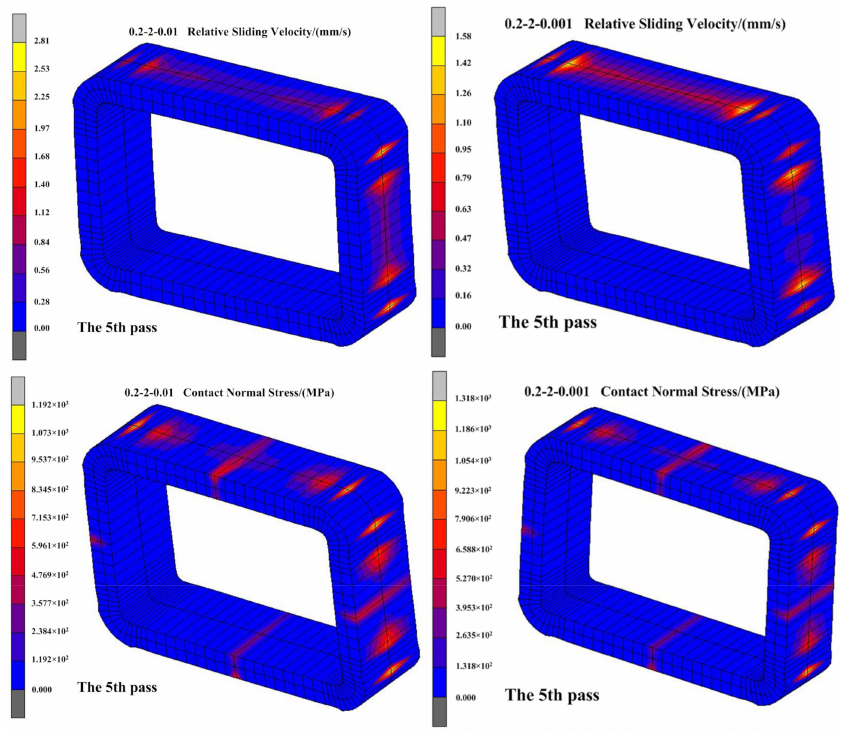
Figure 14. Simulation results of wear parameters under different vertical roller friction